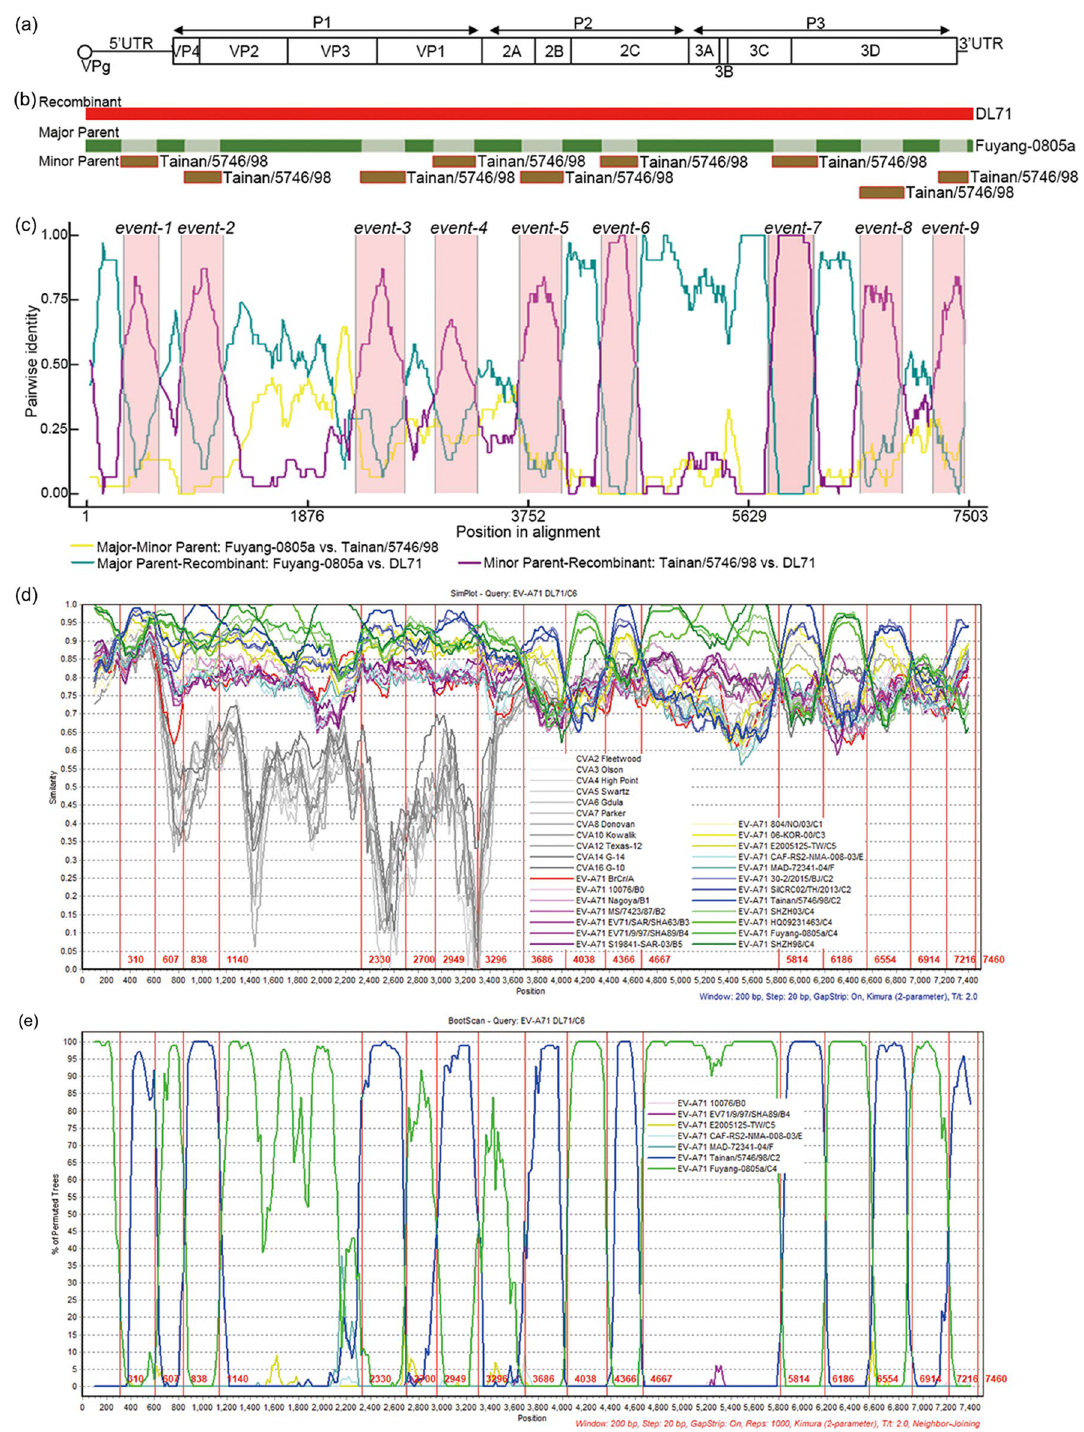
Figure 3. Recombination analyses of DL71. ( a ) Graphical representation of EV-A71 genome. ( b ) A schematic map of recombination within DL71 genome. DL71 genome is shown as a red rectangle. The backbone of DL71 is derived from the major parent (green rectangles), while other genetic components of DL71 is derived from the minor parent (brown rectangles). ( c ) The plot display of 9 recombination events in DL71 genome identified by RDP4. ( d ) The genome of DL71 was used as the query sequence in the Similarity plot analysis. ( e ) The genome of DL71 was used as the query sequence in the BootScan analysis. The vertical red line indicates the breakpoint